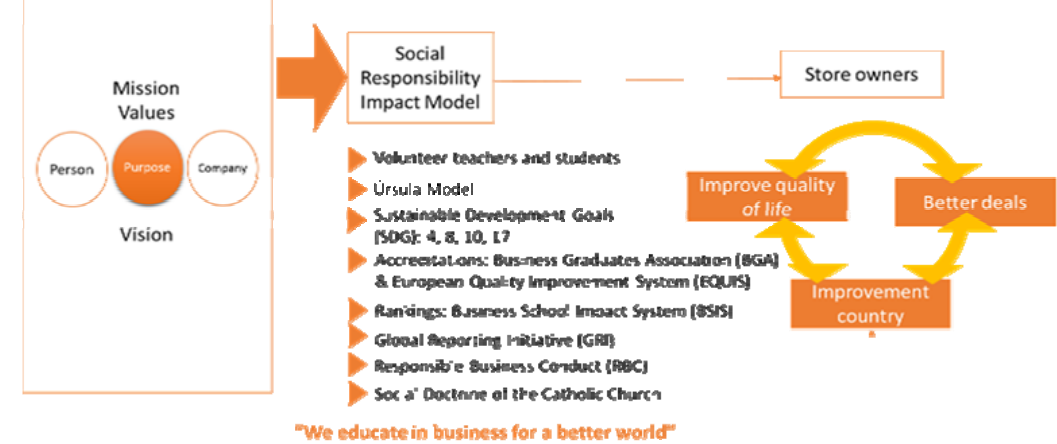
Figure 2. Impacts of the i4.0 educational program that aim to generate shared value and competitive organizations (Ramírez, Rojas, and Albeiro, 2020)